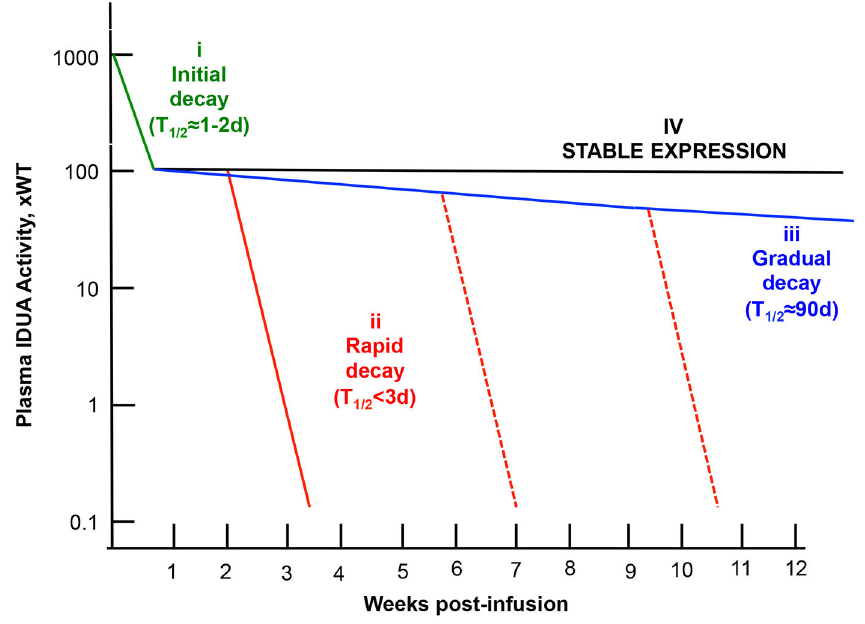
Figure 4. Summary of quantitative evaluation of transgene expression in mice following hydrodynamic delivery to the liver. Three decay rates can account for all of the profiles of expression that we have observed under about 128 different combinations of experimental variables. These decay rates are: initial (i), associated with promoter silencing [8], green line; rapid (ii), associated with loss of plasmids and transgenes, red line; and gradual (iii), blue line. Stabilized expression (iv), black line, at levels >100WTdeemed therapeutic [8] was attained only with LSP, transposition using SB 100X transposase and a transient 4-dose immunosuppression with CP administered intraperitoneally around the time of hydrodynamic delivery. We hypothesize that the delayed loss of expression (red dashed lines, mice 25 and 27 in Figure 2F), that has the same half-life of <3 days, is rapid as (ii). doi: